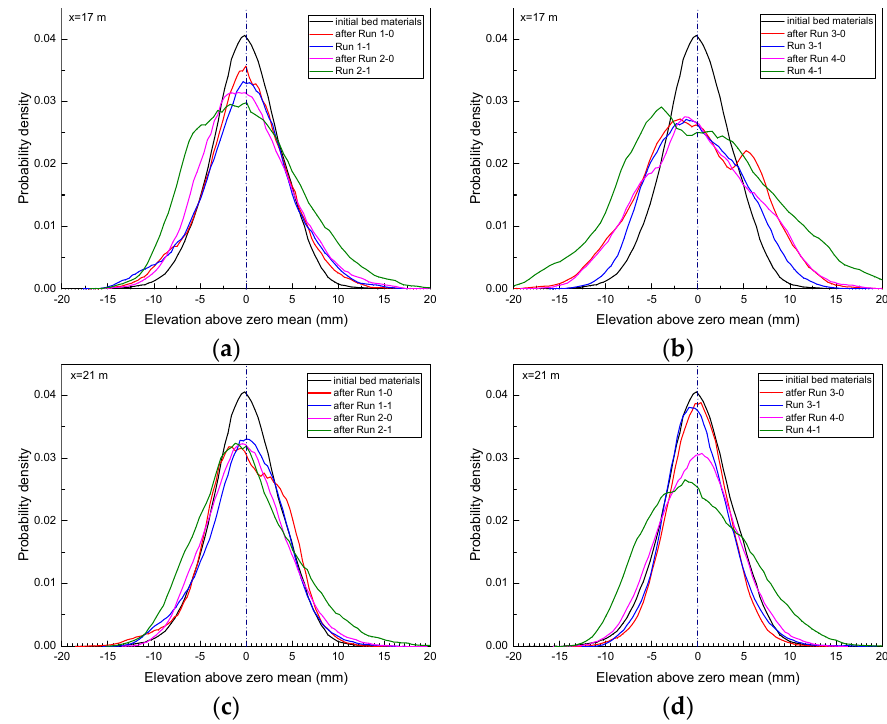
Figure 5. Probability density curve of riverbed elevation over average bed surface (x = 17 and 21 m): ( a ) Run 1~2, x = 17 m; ( b ) Run 3~4, x = 17m; ( c ) Run 1~2, x = 21 m; and ( d ) Run 3~4, x = 21 m.